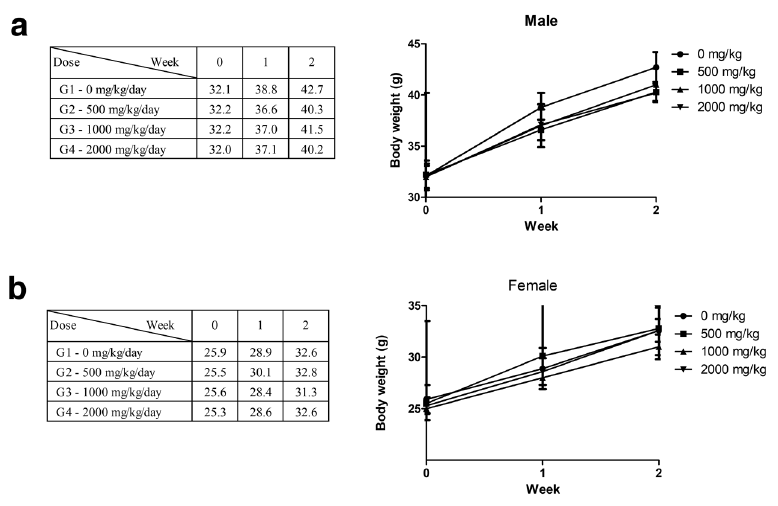
Figure 2. ( a , b ) Body weight of male and female mice measured once a week for 2 weeks following a single oral dose of polyethylene microplastics.